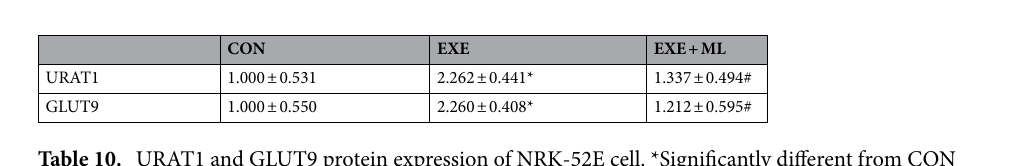
Table 10. URAT1 and GLUT9 protein expression of NRK-52E cell. *Significantly different from CON ( p < 0.05), #Significantly different from EXE ( p <